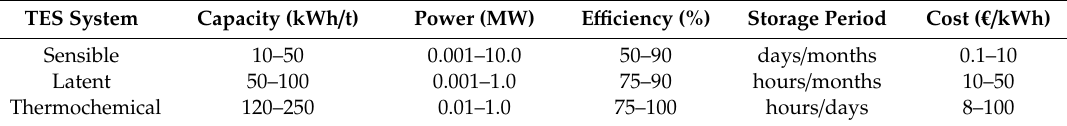
Table 1. Parameters of thermal energy storage systems (TESs)